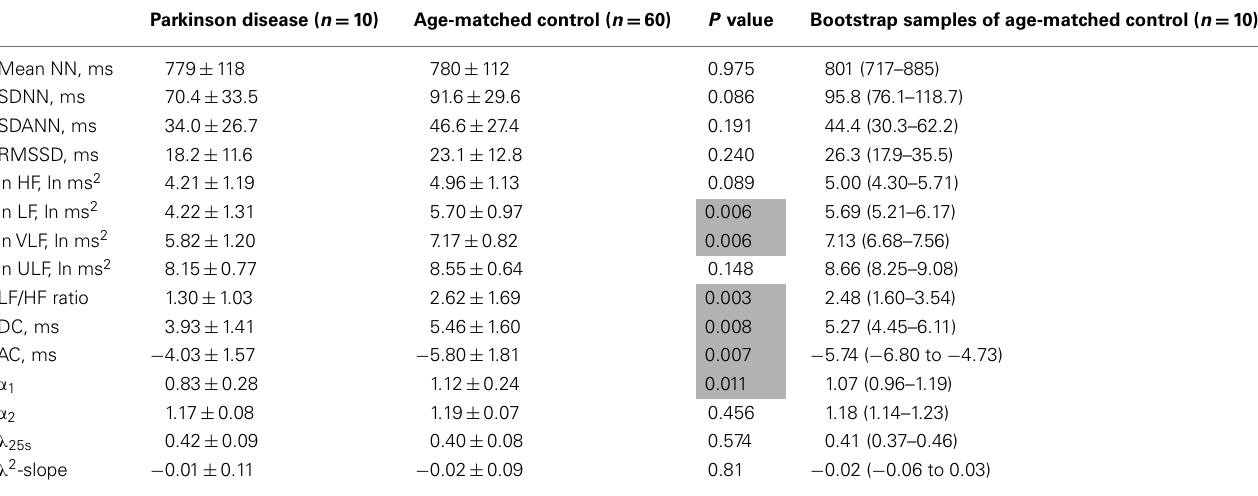
Table 4 | Heart rate variability measures in patients with Parkinson disease and age-matched